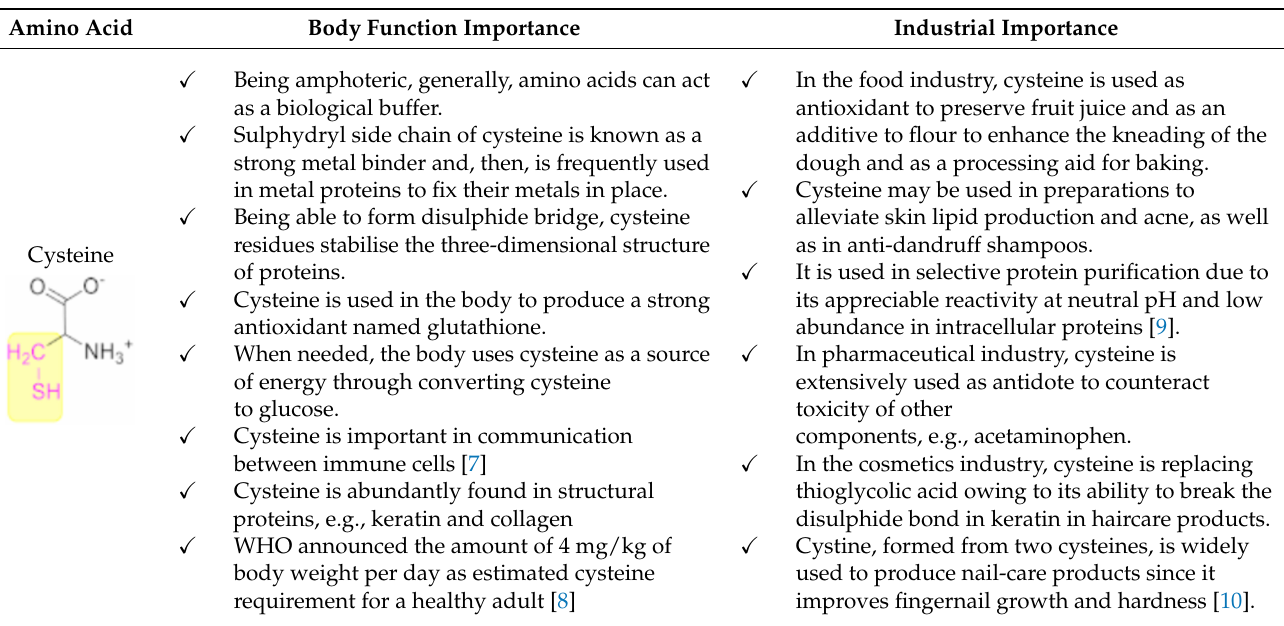
Table 1. Highlighted functions of electroactive amino acids. (Note that the first column represents structures at neutral pH). Amino Acid Body Function Importance Industrial